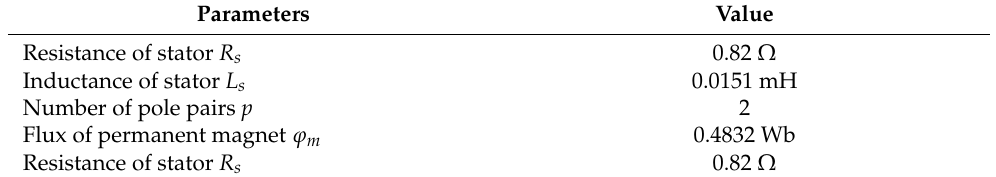
Table 5. Parameters of PMSG.